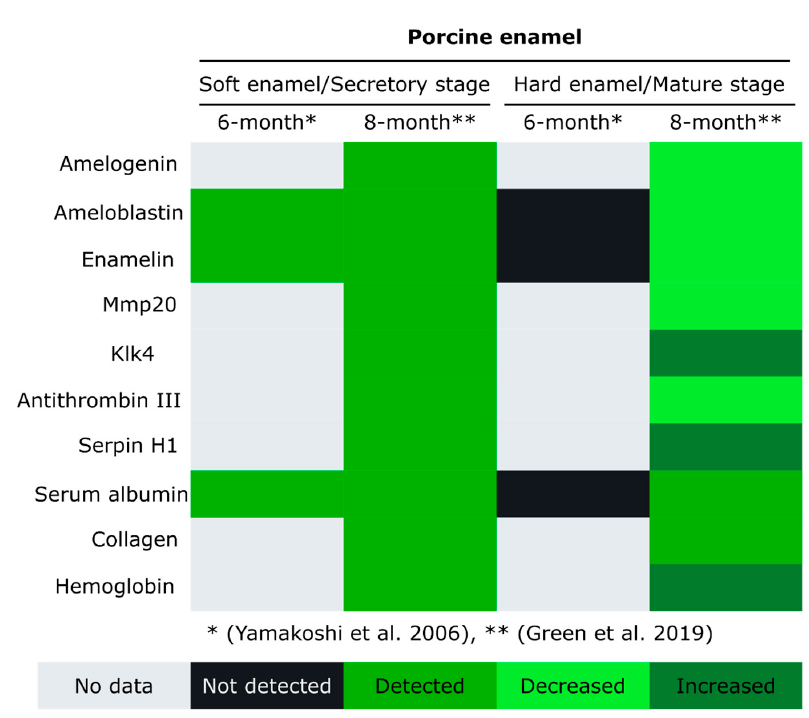
Figure 4. Overview of proteins detected in enamel from permanent molars of 6-months-old [112] and 8-months-old pigs [15]. The chart distribution is based on the protein detection in soft enamel and hard enamel, described as secretory and mature stages, respectively.